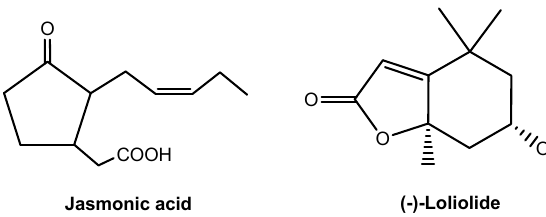
Figure 8. Soil-borne signaling chemicals in plant-organism belowground interactions.